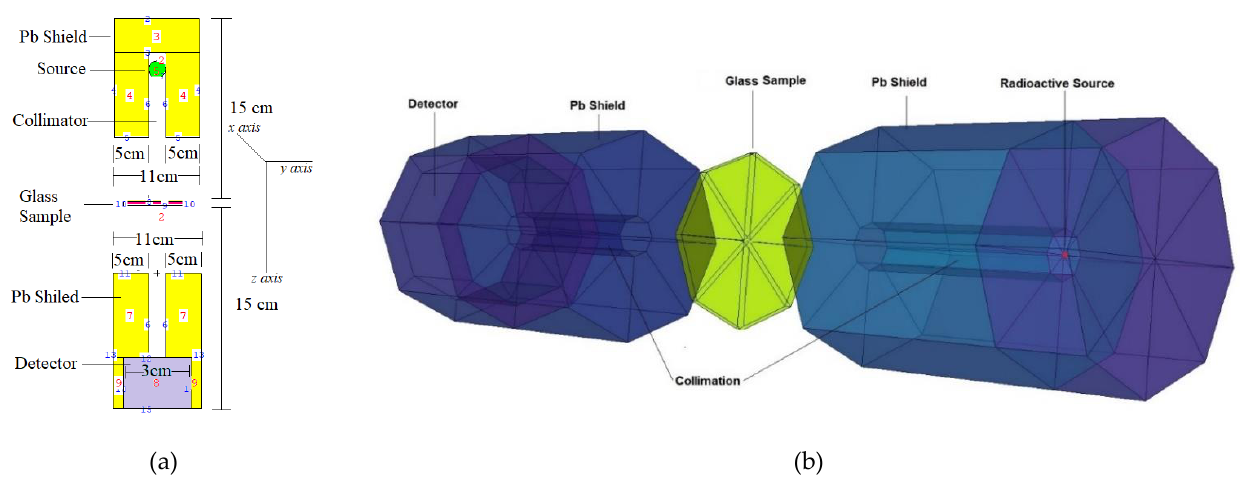
Figure 2. MCNPX simulation setup for gamma-ray-transmission studies: ( a ) 2D view with dimensions, ( b ) 3D view of setup obtained from MCNPX Visual Editor.